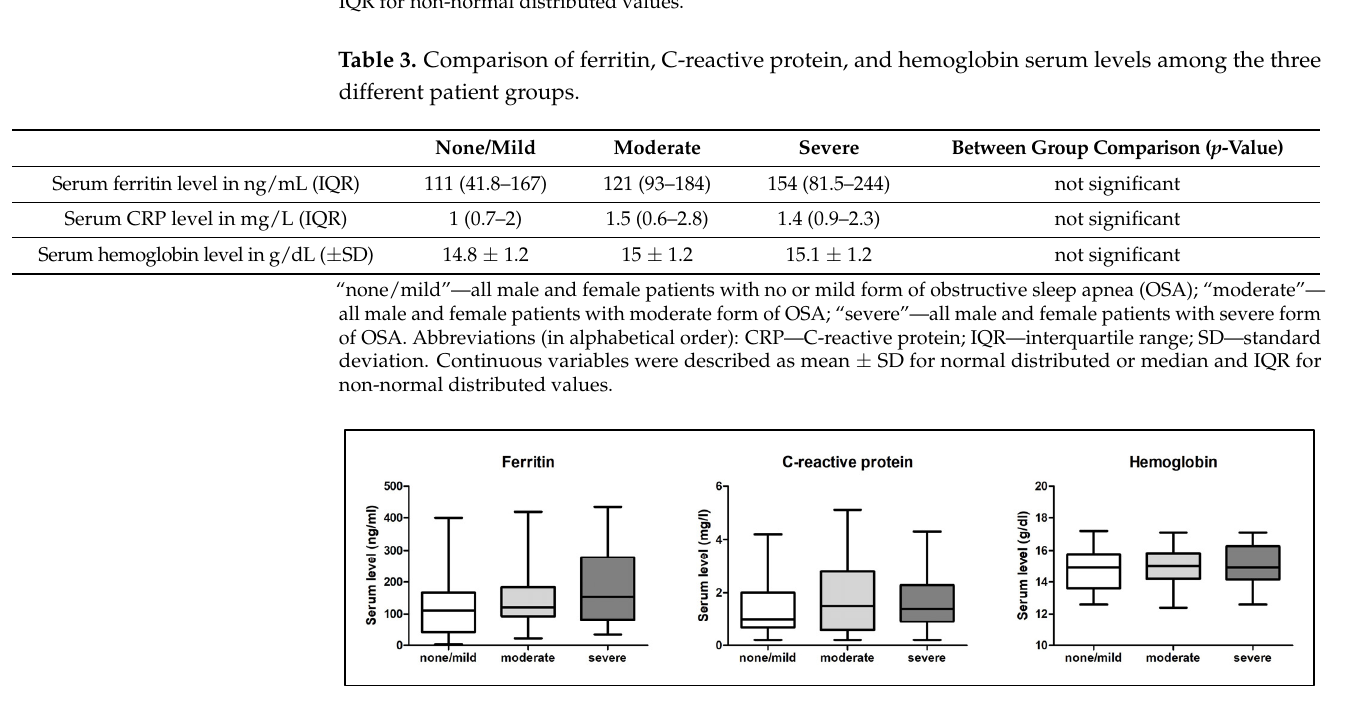
Figure 1. Ferritin, C-reactive protein, and hemoglobin serum levels among the three different patient groups. “none/mild”—all male and female patients with no or mild form of obstructive sleep apnea (OSA); “moderate”—all male and female patients with moderate form of OSA; “severe”—all male and female patients with severe form of OSA. Within the boxplots, median and IQR are presented.